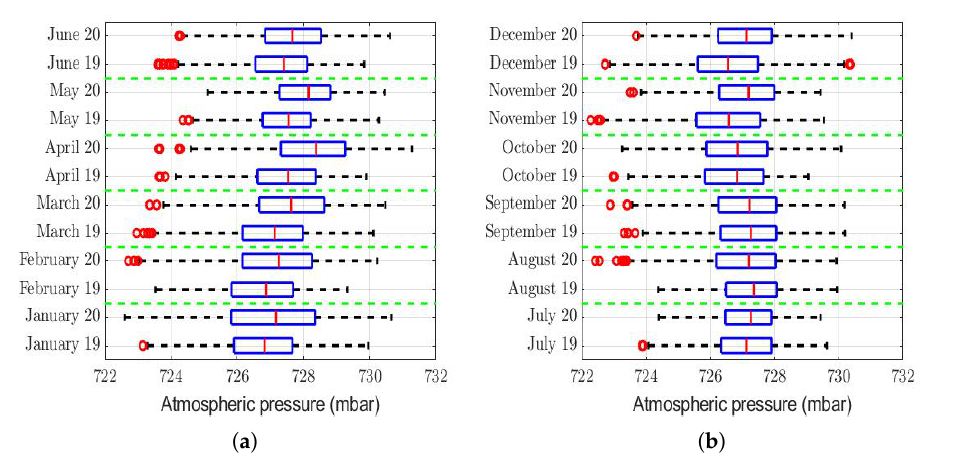
Figure 10. Box plot of the atmospheric pressure (mbar): 2019 vs. 2020. The red circles represent the outliers. ( a ) First semester. ( b ) Second semester.